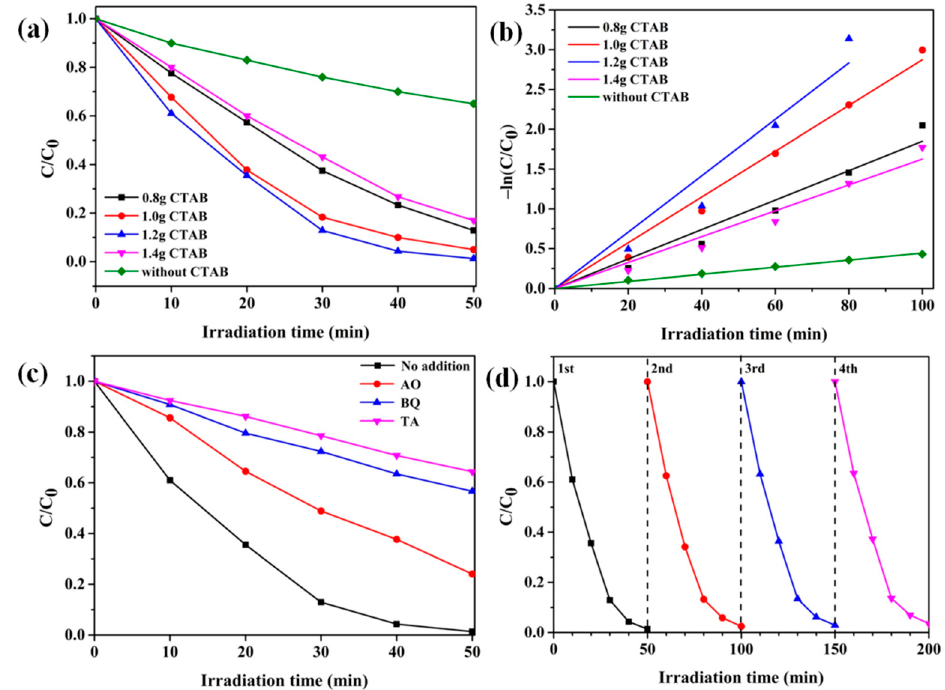
Figure 9. ( a ) The comparison of photocatalytic activity with different ZnO samples under UV-vis irradiation; ( b ) linear fit between − ln (C/C 0 ) and irradiation time among different ZnO samples; ( c ) trapping experiments of active species and ( d ) Cyclic degradation curve of ZnO nano-rod arrays synthesized with 1.2 g CTAB.